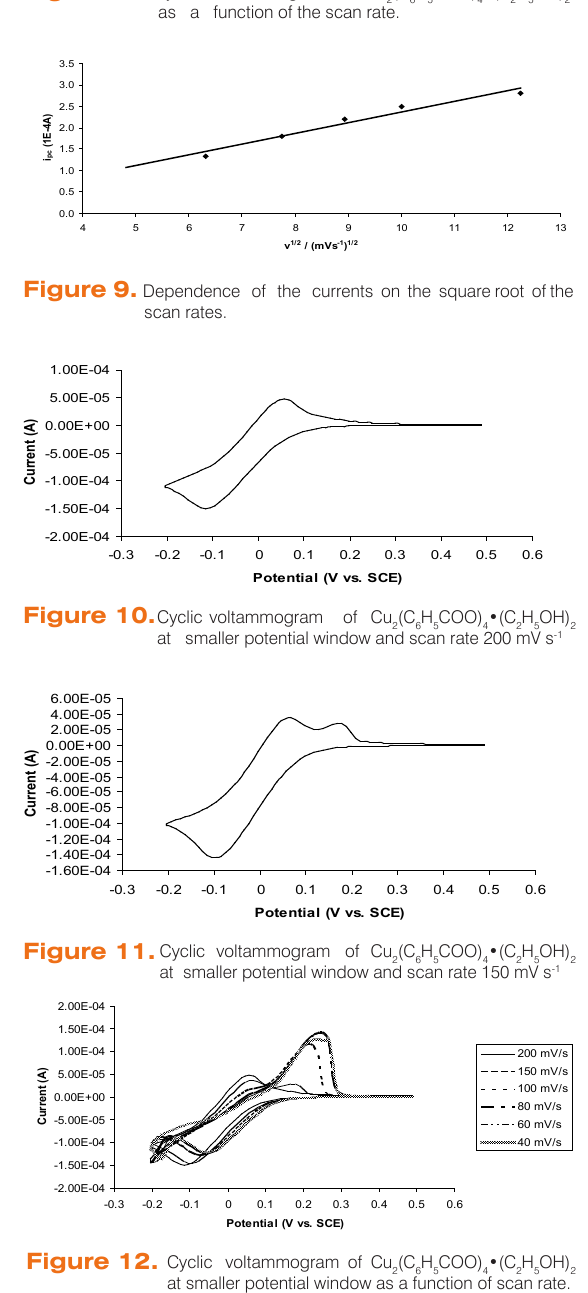
(C H COO) •(C H OH) 2 6 5 4 2 5 2